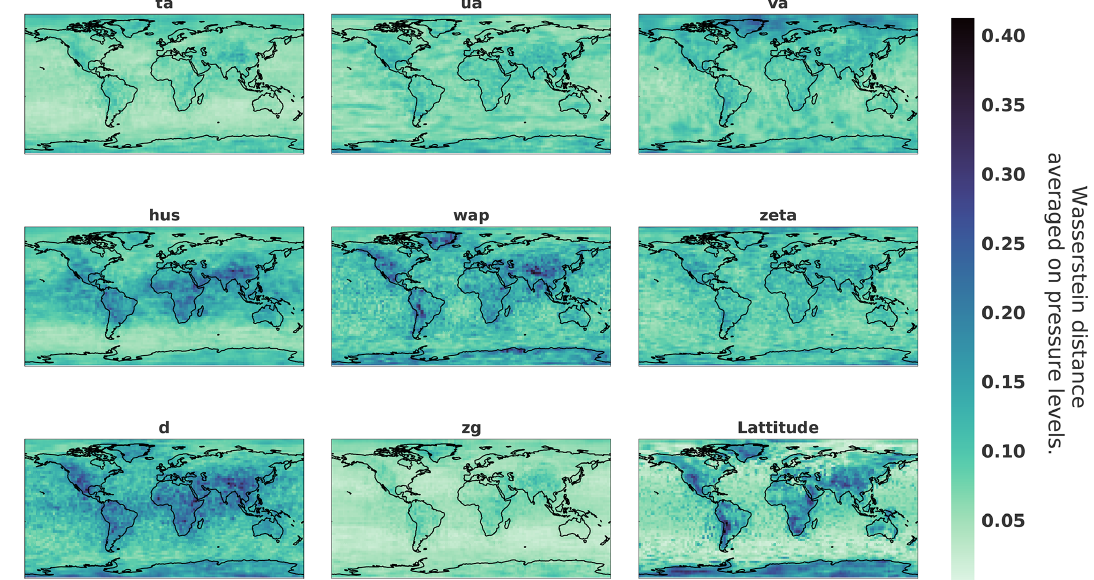
Figure 16. Wasserstein distance between 5000 datasets and generated samples on each pixel and each channel.